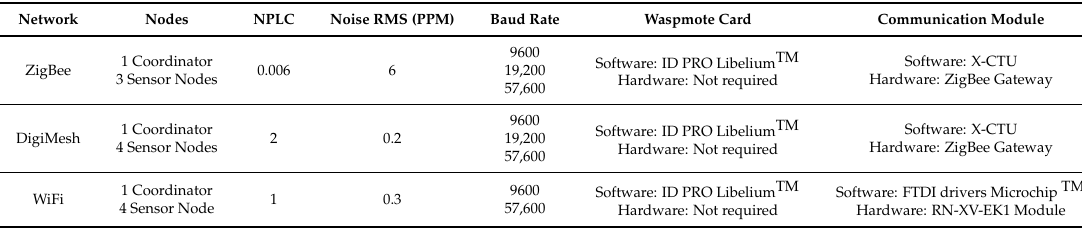
Table 2. Relevant parameters in the data collection of energy